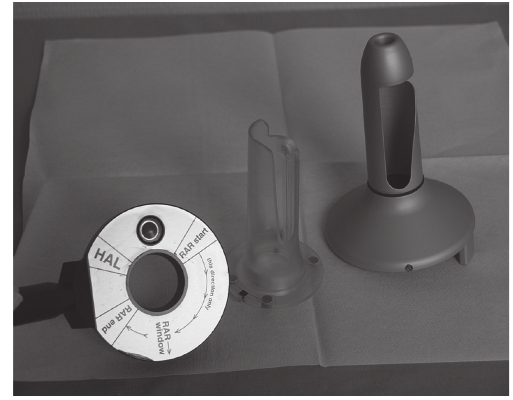
Figure 1: A.M.I. DGHAL-RAR